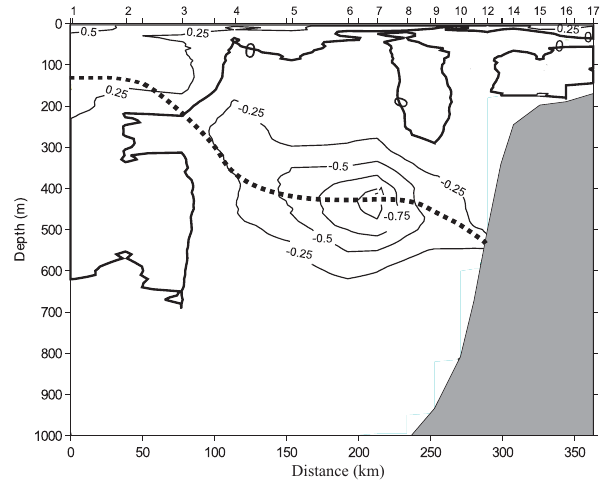
Fig. 9. Temperature anomalies, difference in temperature between years with positive volume flux anomalies and negative volume flux anomalies. The dotted line, which is the time-mean isohaline at S =35, indicates the boundary between AW and Arctic water. The numbers at the upper axis refers to the standard hydrographic sta-